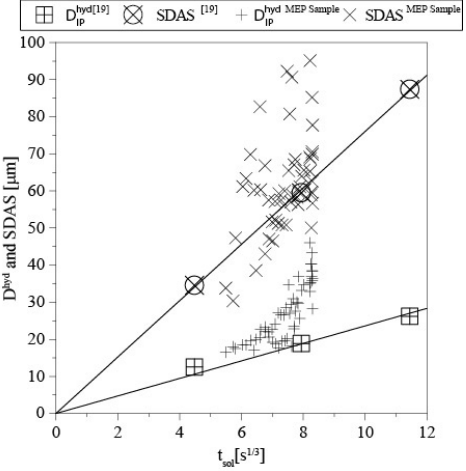
hyd D of the intradendritic space IP